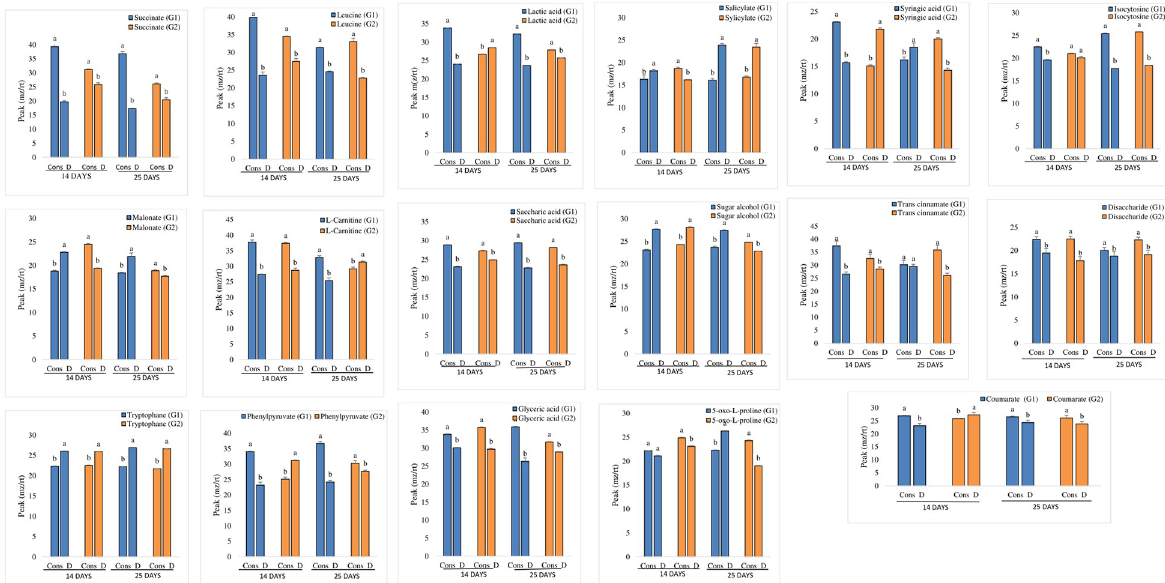
Fig 3. Significantly different levels of selected metabolites (ANOVA, P � .05, Tukey’s honest significant difference) in the leaves of two chickpea varieties under consortium and drought conditions at 2 time points (14 and 25 days). G1: drought-sensitive chickpea genotype (Punjab Noor-2009); G2: drought-tolerant chickpea genotype (93127). Error bars represent standard errors of the mean ( n = 6) at each time point. Cons = consortium, D = drought. Different letters indicate significant differences ( P < .05) among treatments (consortium vs drought) for a genotype for mz / rt peak in a particular time